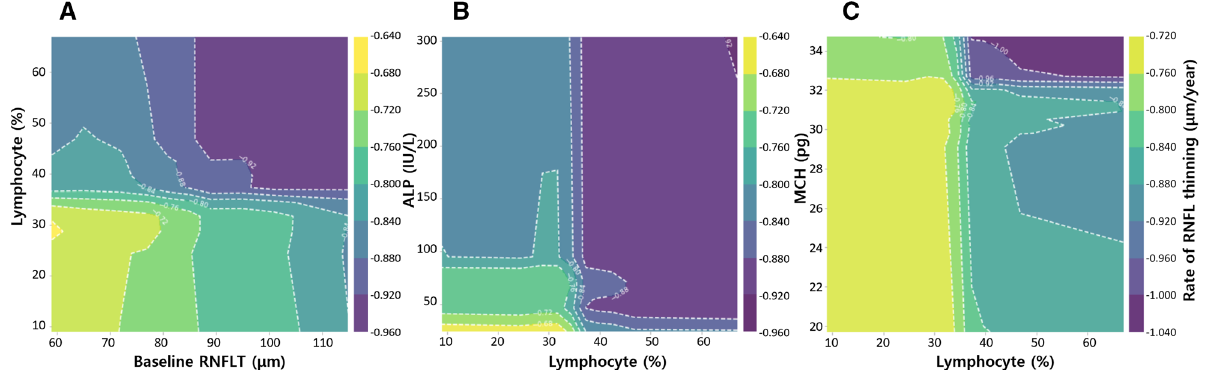
Figure 2. Partial interaction plots showing interactions between two selected factors that affect the rate of RNFL thinning. The scale bar on the right indicates the rate of RNFL thinning. Interactions between baseline RNFLT and lymphocyte ratio ( A ), lymphocyte ratio and ALP ( B ), and lymphocyte ratio and MCH ( C ). These results indicate correlation, not causality. RNFL retinal nerve fiber layer, RNFLT retinal nerve fiber layer thickness, ALP alkaline phosphatase, MCH mean corpuscular